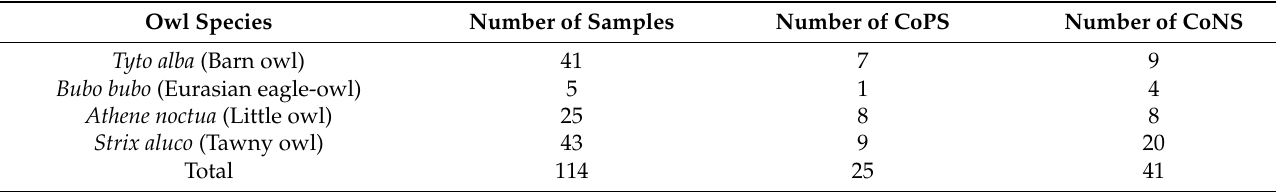
Table 1. The distribution of CoNS and CoPS among the four owl